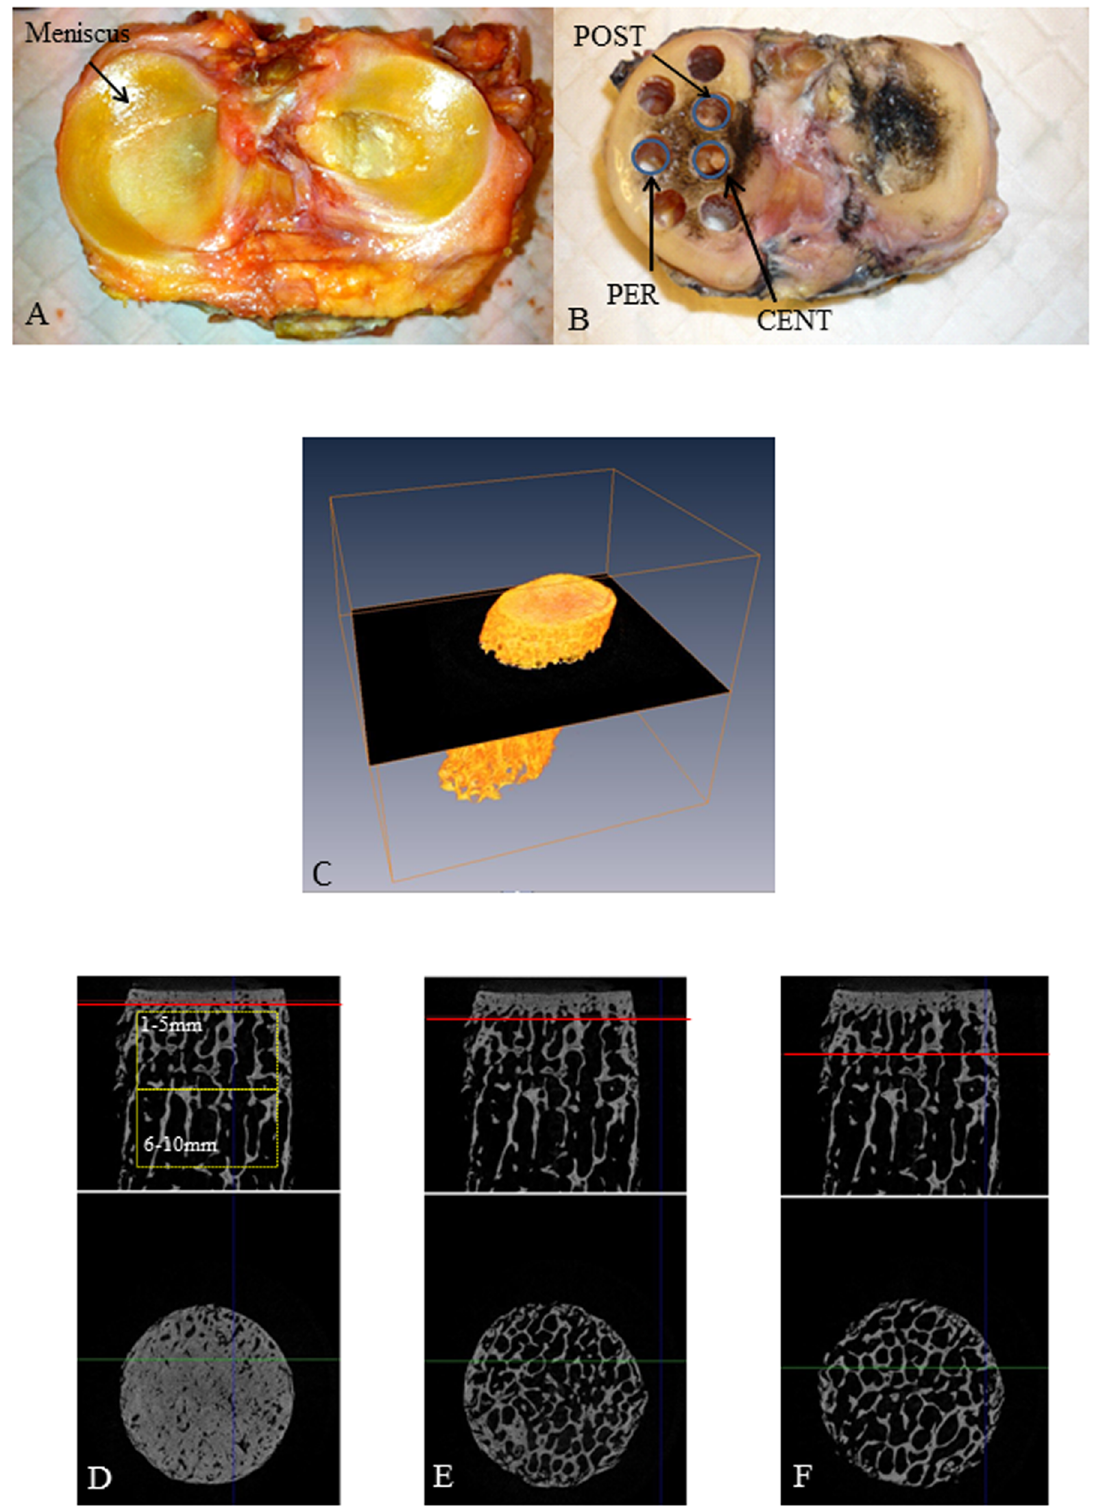
Fig 1. Sampling sites and micro-CT analyses. (A) Tibial plateauwith meniscus. (B) Tibial plateauwithout meniscus and osteochondral plug samplingsites. (C) Post-acquisition rotation of the micro-CT images ensuredthat each slice was perpendicular to the cartilagesurface. (D-E-F) Structure of the subchondral plate (SCP) and subchondral trabecularbone